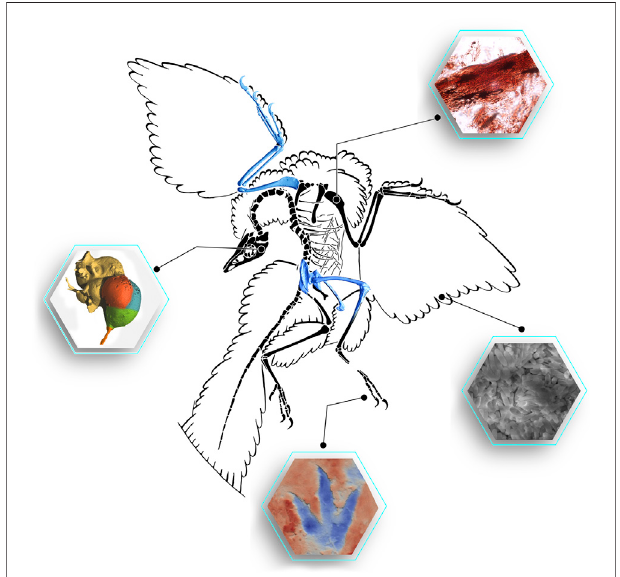
FIGURE 1 | The famous Berlin specimen of the early bird Archaeopteryx summarizingsomeinnovativeoutcomesthatcanbedevelopedthankstonew techniques and methods like digitization, 3D reconstruction of soft tissues, track morphology and neuroanatomy or the retrieval of fossil cells and molecules(imagesmodi fi edfrom Fieldetal.,2013and Castaneraet al.,2018, and courtesy of D. Vidal and J. Wiemann).